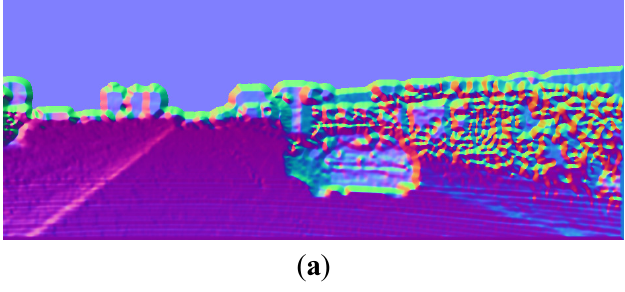
; ( c ) Normal projection in X W